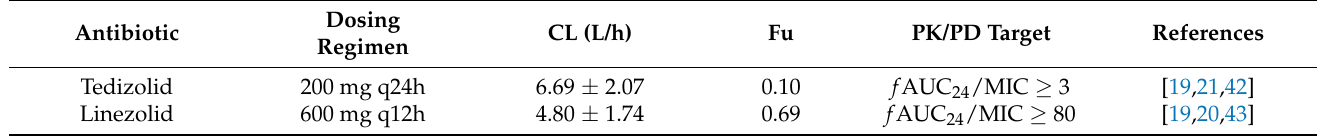
Table 8. Pharmacokinetic parameters and PK/PD targets of tedizolid and linezolid used for Monte Carlo simulations. CL data are expressed as mean ± standard